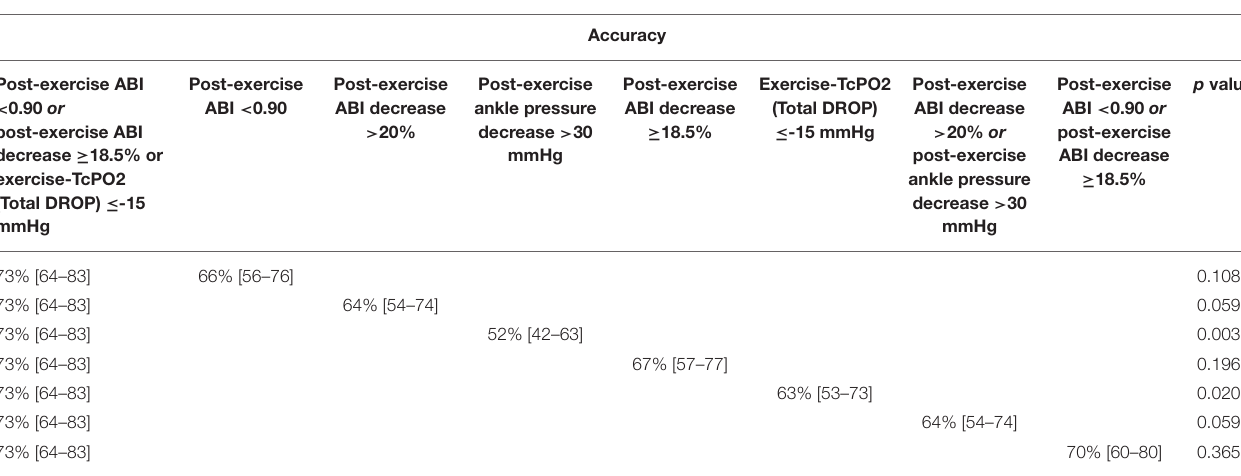
TABLE 3 | Comparisons of the accuracies of the different